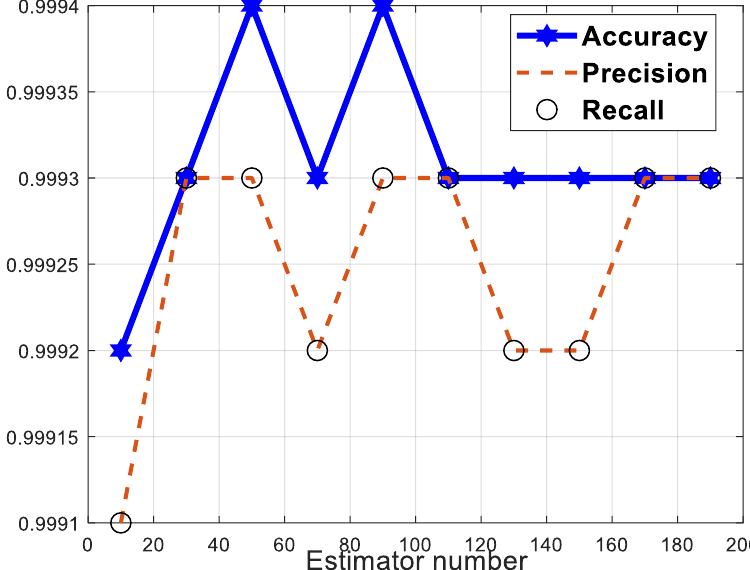
Figure 1. QSVM performance: accuracy, precision, and recall parameter visualization.